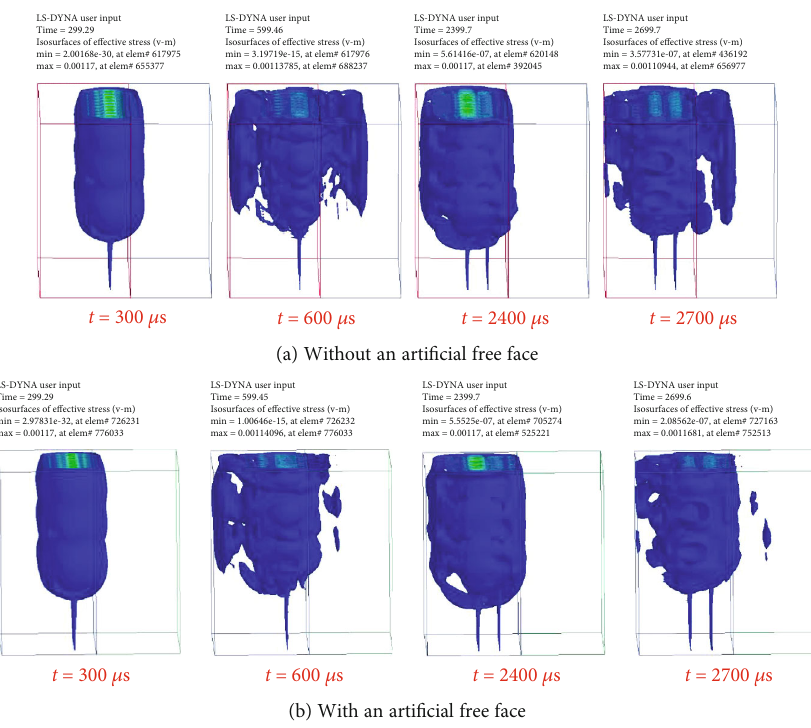
Figure 13: Comparison of bedrock stress